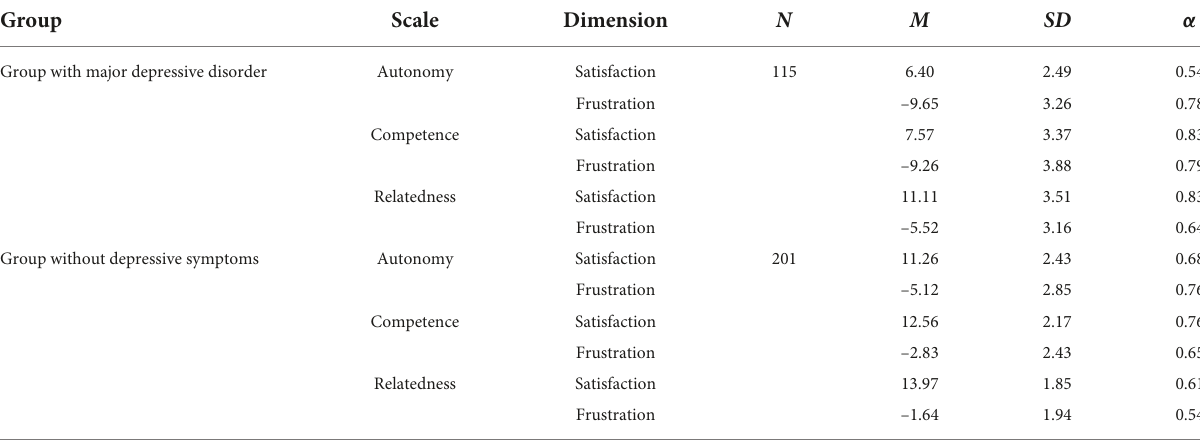
TABLE 2 Means ( M ), standard deviations ( SD ), and Cronbach’s alpha ( α ) by group for the six subscales of the Basic Psychological Need Satisfaction and Frustration Scale (BPNSFS).